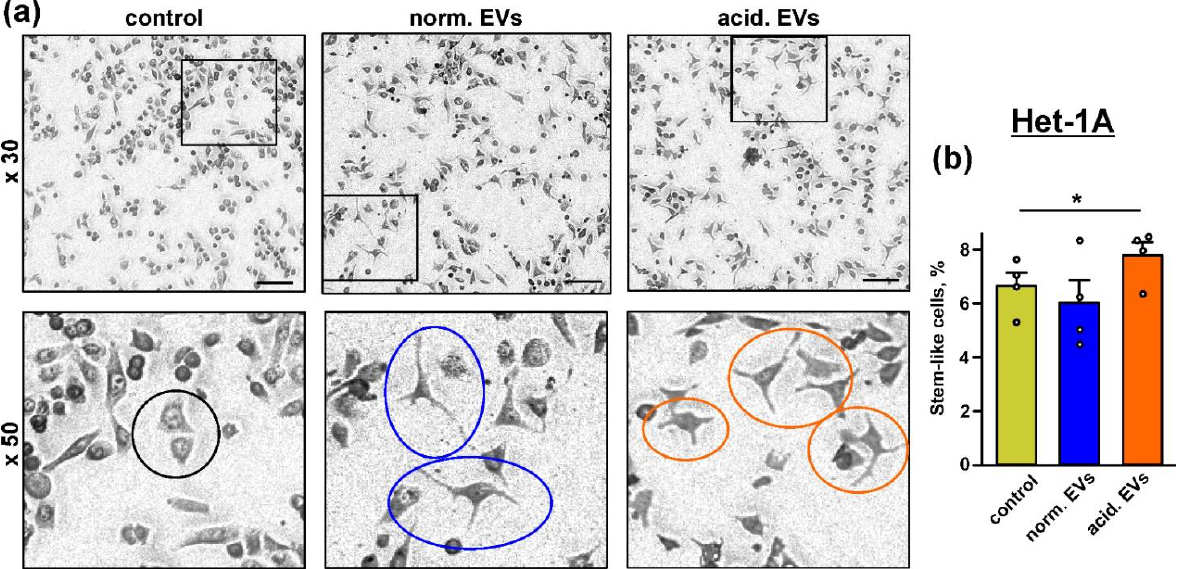
Figure 3. Influence of “normal” and “acidified” EVs on the keratinocytes morphology: ( a ) representative pictures showing the examples of the normal morphology in the untreated Het-1A keratinocytes (black circle) and the “stem”-like morphology in the keratinocytes upon the incubation with “normal” (blue circles) and “acidified” (red circles) EVs. Scale bar 50 μm; ( b ) number of the keratinocytes with the “stem”-like morphology in the untreated cells (control) and after the 48 h incubation with “normal” and “acidified” EVs. Data presented as % of the cells with the “stem”-like morphology ± SEM ( n = 4); * ( p < 0.05) indicates significant difference between the data groups by the one-way ANOVA followed by Tukey’s post hoc test.